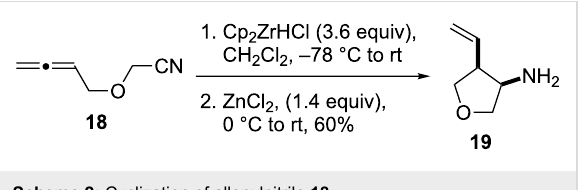
Table 4: Cyclative reductive couplings.